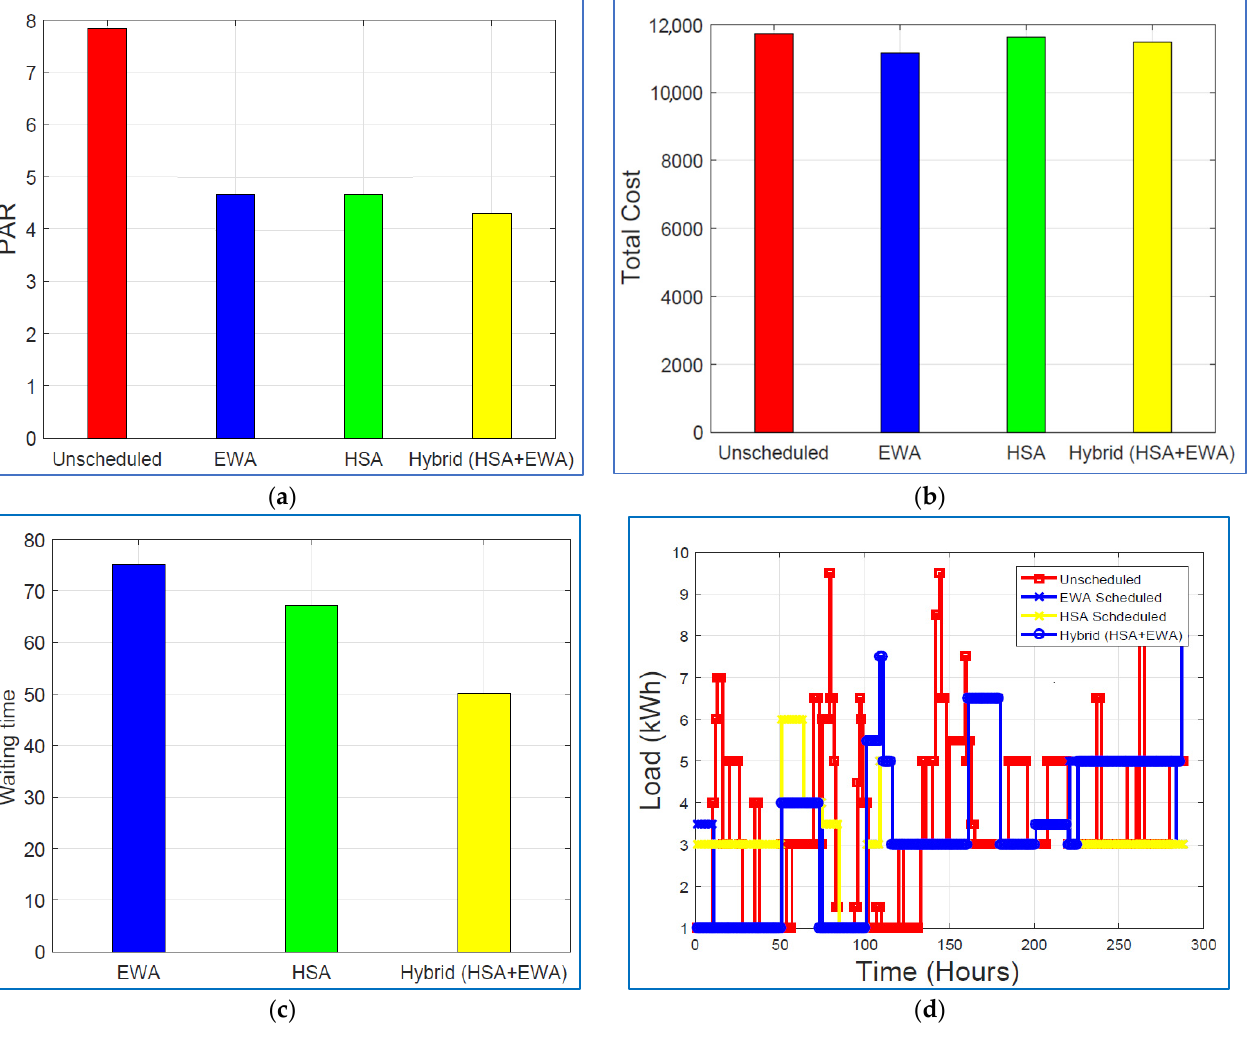
Figure 6. ( a ) 5 Minute OTI for PAR. ( b ) 5 Minute OTI for Total Cost. ( c ) 5 Minute OTI for User Figure 6. ( a ) 5 min OTI for PAR. ( b ) 5 min OTI for Total Cost. ( c ) 5 min OTI for User Comfort. Comfort. ( d ) 5 Minute OTI for Total Load. ( d ) 5 min OTI for Total